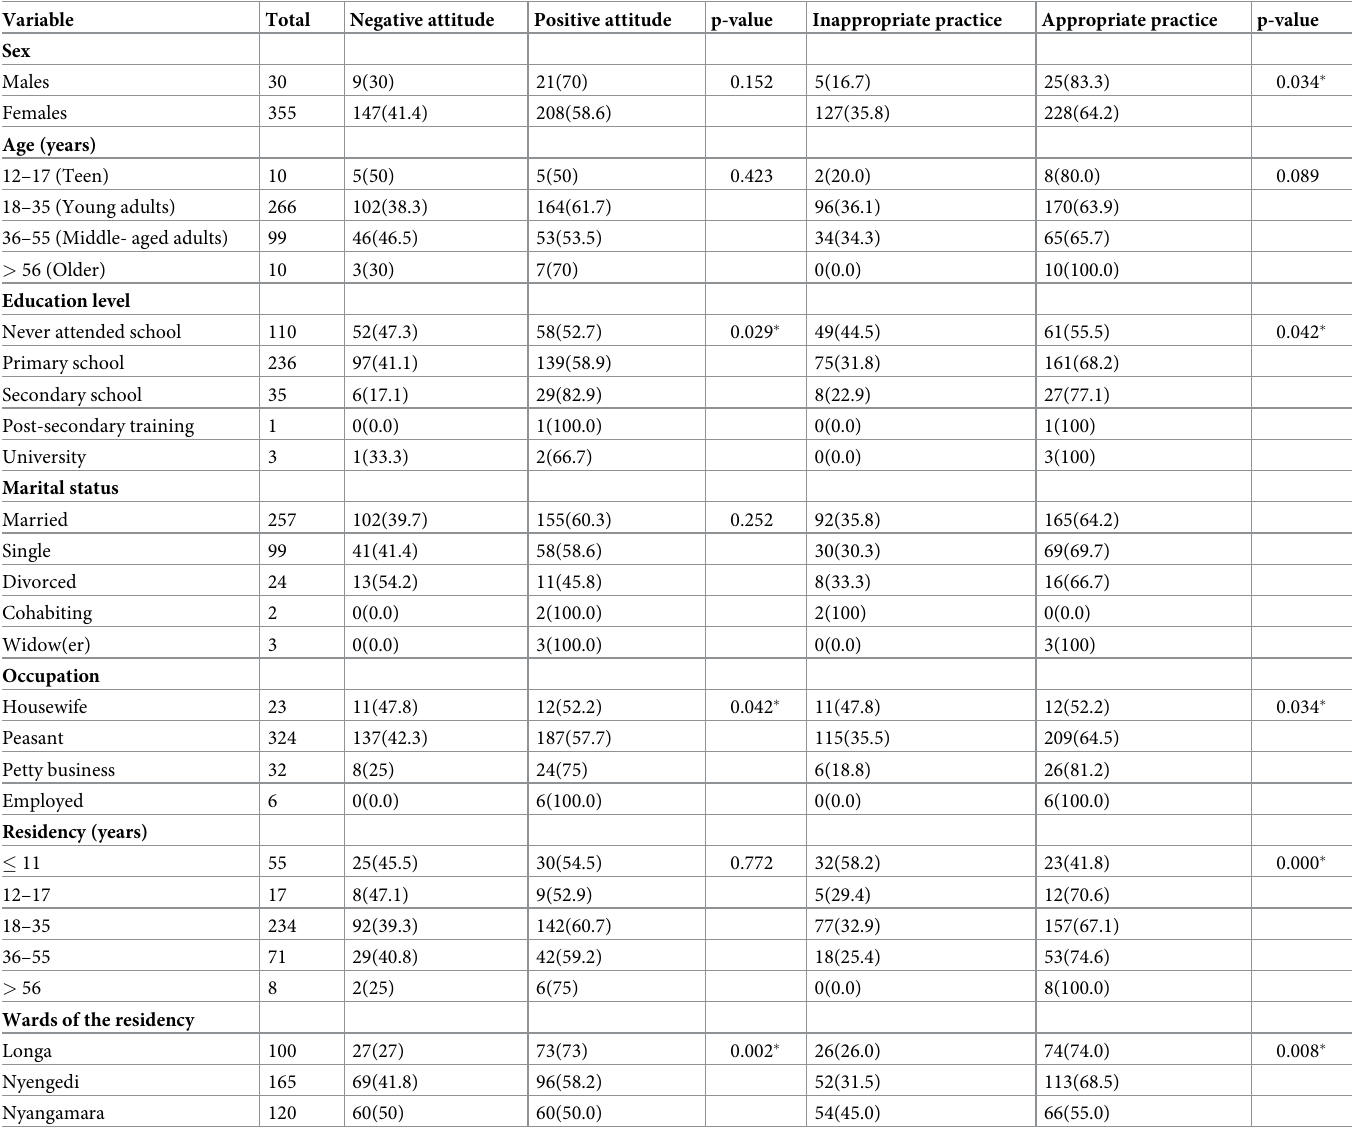
Table 5. Influence of socio-demographic characteristics of the parents/guardians on the attitudes and practices on the urogenital schistosomiasis among the study participants (n =